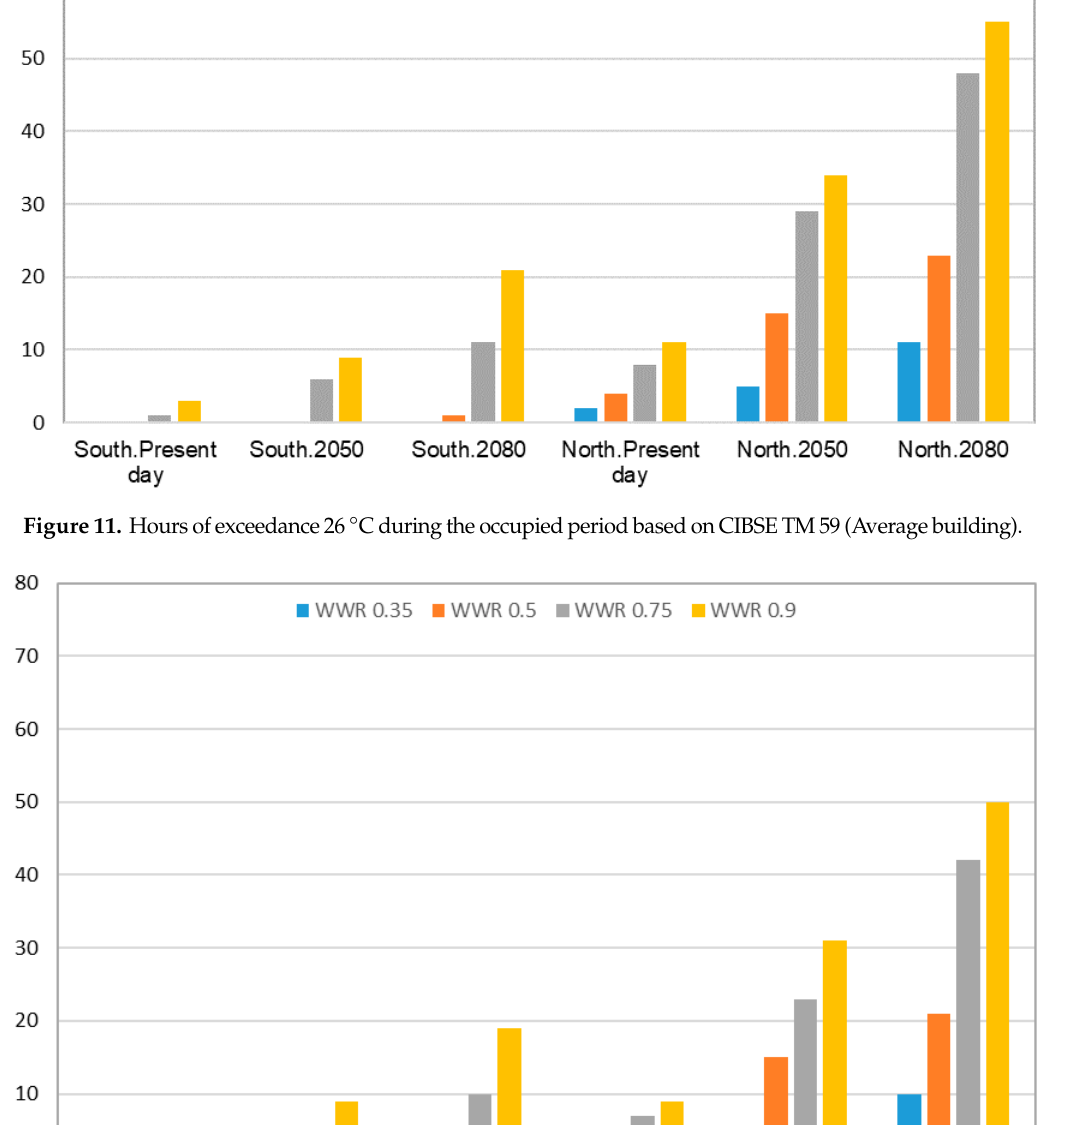
Figure 12. Hours of exceedance 26 °C during the occupied period based on CIBSE TM 59 (General building).